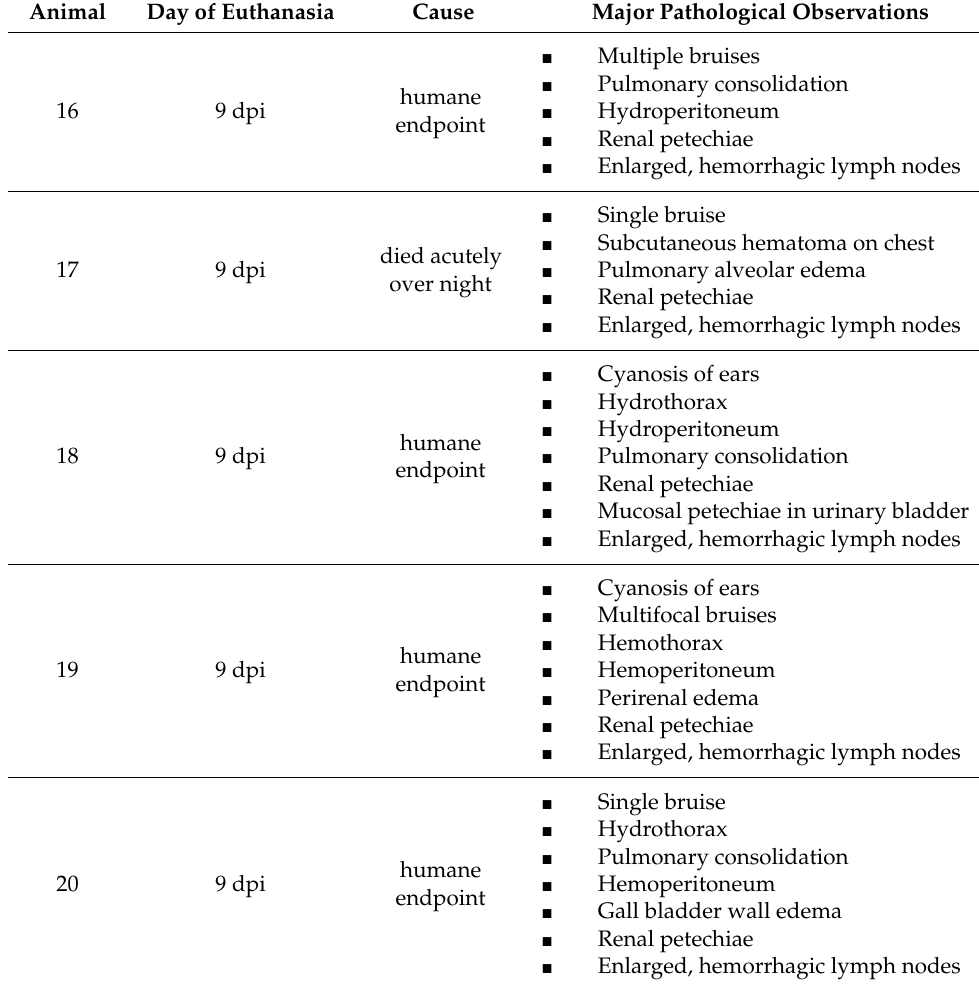
Table 2. Overview of pathological findings per animal from trial B.